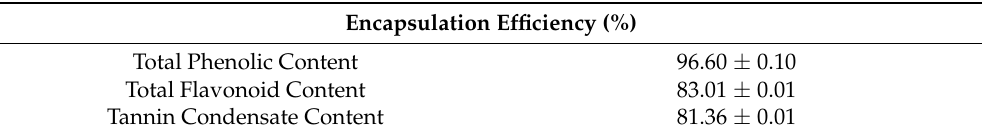
Table 2. Values obtained from the encapsulation efficiency of phenolic compounds in the microparticle (MP